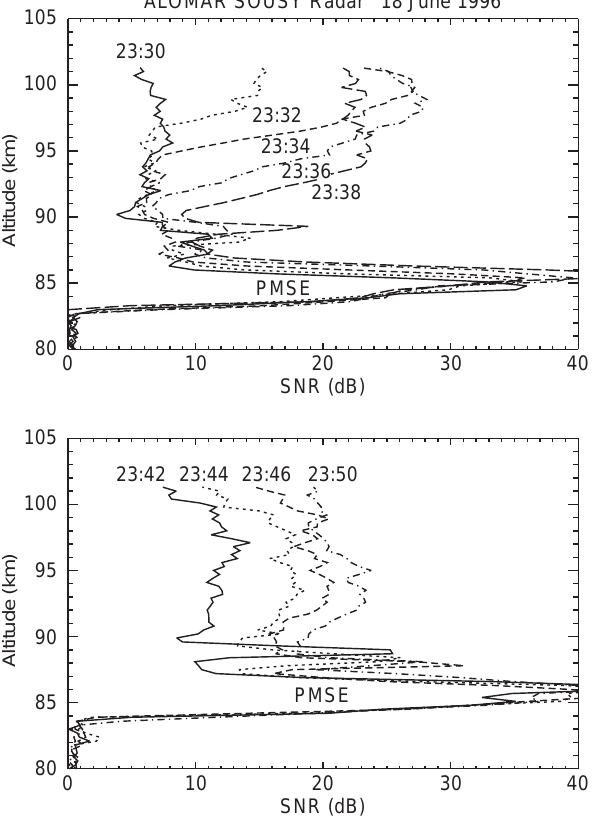
Fig. 3. Sequences of height profiles of the signal-to-noise ratio for di(cid:128)erent time intervals recorded with the vertically pointing beam of the ALOMAR SOUSY radar on June 18, 1996. The saturated echoes of the PMSE are